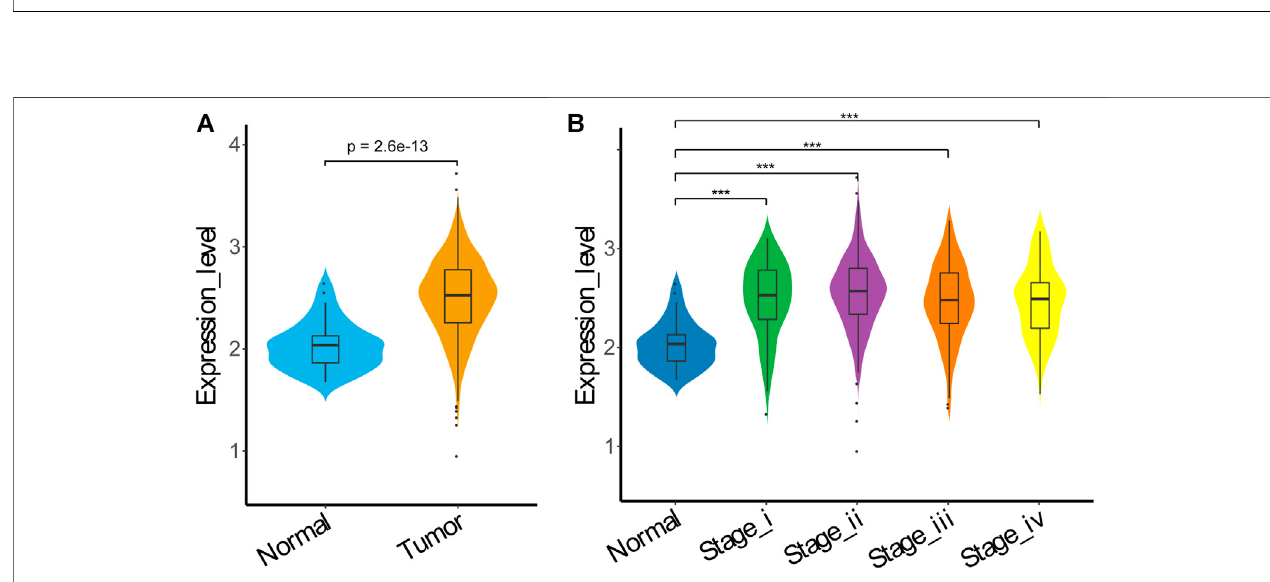
FIGURE 6 | HSP90 α expression in TCGA COAD. (A) HSP90 α expression in TCGA COAD samples from normal tissue ( n (cid:1) 40) or tumor tissue ( n (cid:1) 458); (B) HSP90 α expression in TCGA COAD samples from normal tissue ( n (cid:1) 40) or different tumor stage tissue (stage Ⅰ : n (cid:1) 78, stage Ⅱ : n (cid:1) 183, stage III: n (cid:1) 132, stage IV: n (cid:1) 65). Data were analyzed using Wilcoxon Rank Sum